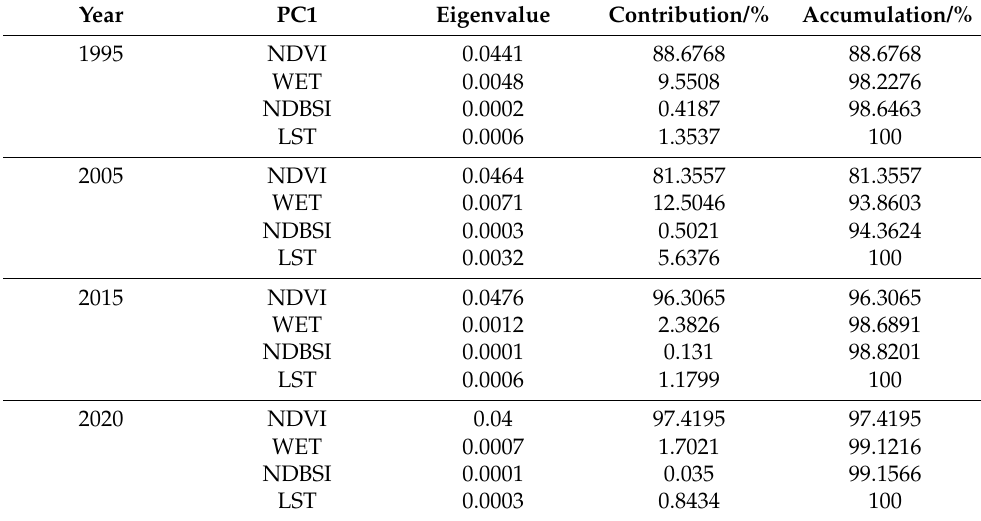
Table 2. Principal component analysis index and